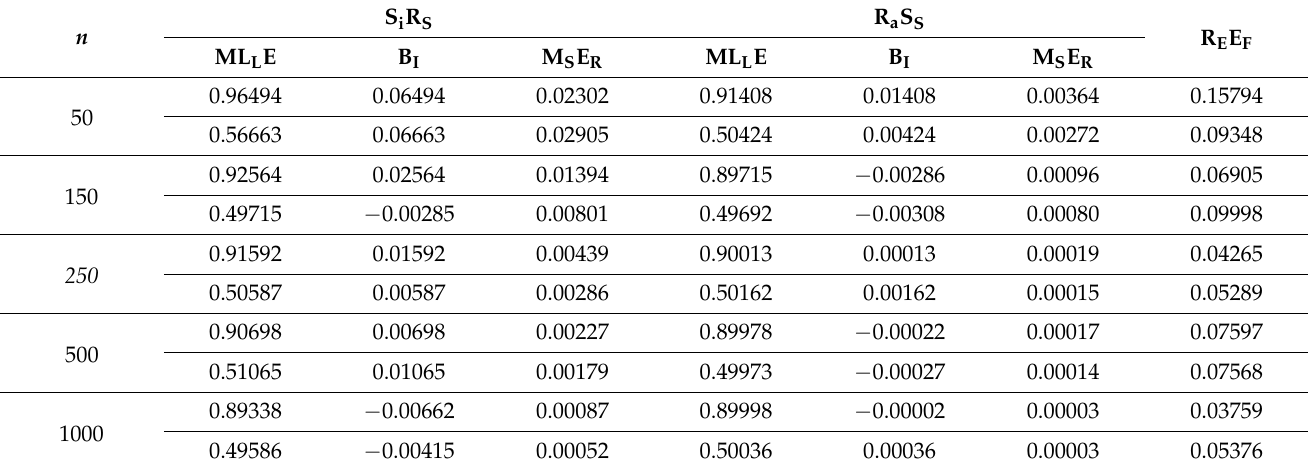
Table 1. The ML L E s , B I s, M S E R , and R E E F of the KMB X model under S i R S and R a S S at α = 0.9, β = 0.5.